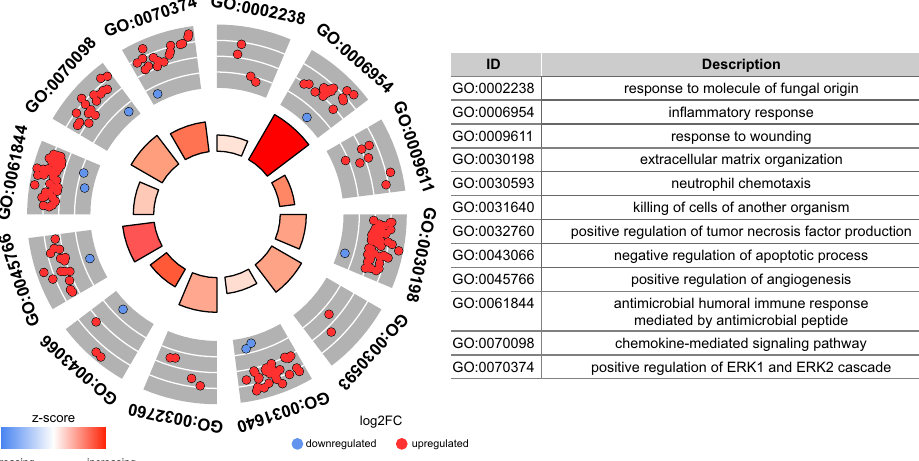
Figure 5. The table on the right side shows the top 15 GO terms enriched for the selected genes from both modules analyzed. On the left, the outer circle’s scatter plots represent the GO terms foldchange values. The z-scores identified and the regulation of its associated genes, based on the log 2 showed in the inner circle were calculated for each BP as z - score = ( up - regulated genes − down - (cid:112) regulated genes ) / total genes .